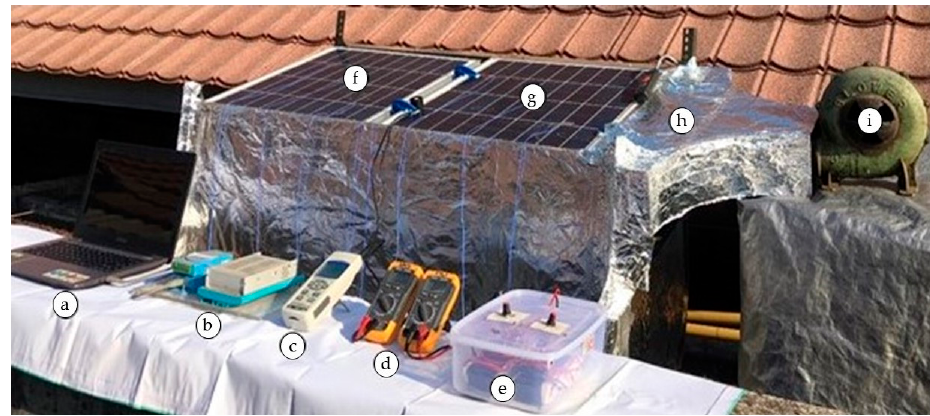
Figure 3. Experimental process: ( a ) Laptop, ( b ) Adam data logger, ( c ) solar power meter, ( d ) amperemeter and voltmeter, ( e ) variable resistor, ( f ) photovoltaic (PV) with heat sinks, ( g ) PV without heat sinks, ( h ) anemometer, and ( i ) fan blower.